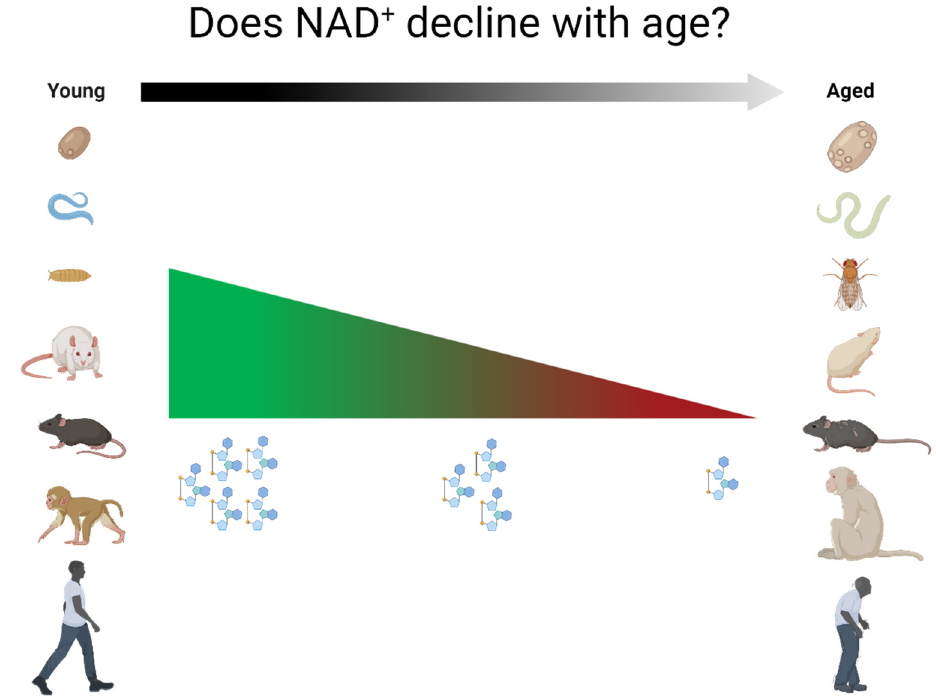
Figure 2. This review discusses the scientific robustness of the claim that NAD + levels decline with age.